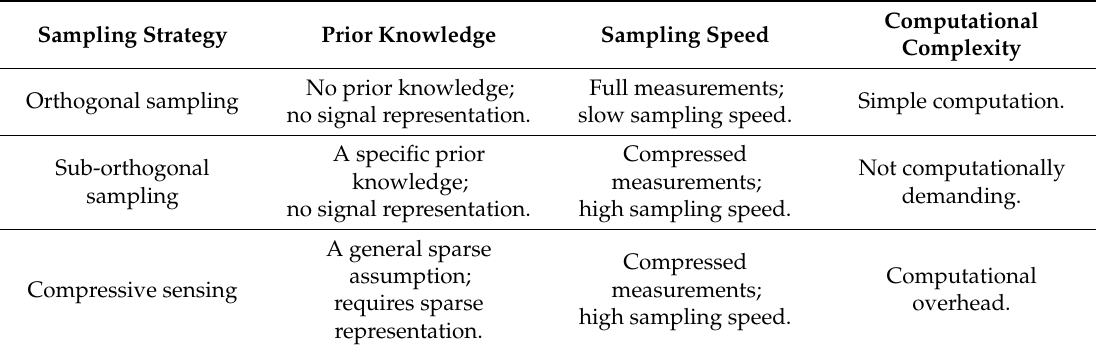
Table 2. A summarized table of three commonly applied sampling strategies in single-pixel imaging